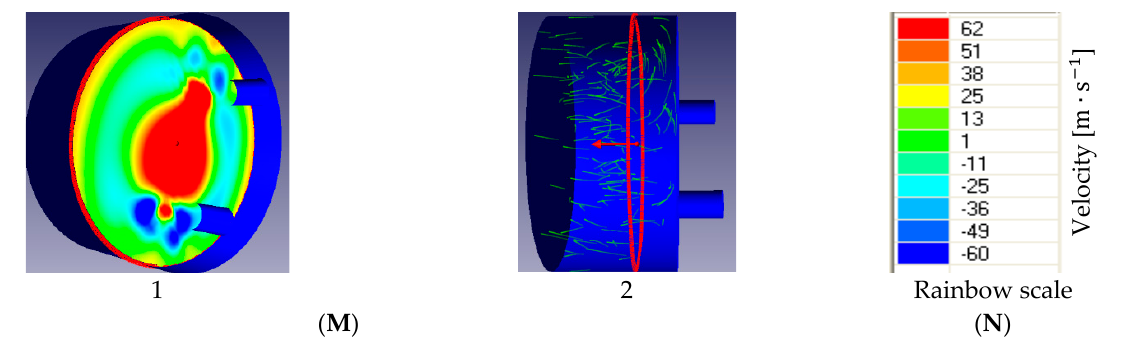
Figure 4. Visualization of the flow pattern through slots of various shapes for slot models in Figure 3: ( A ) for model (a); ( B ) for model (b), r = 0.35 mm; ( C ) for model (b), r = 0.70 mm; ( D ) for model (b), r = 1.59 mm; ( E ) for model (c); ( F ) for model (d); ( G ) for model (e); ( H ) for model (f); ( I ) for model (g); ( J ) for model (h); ( K ) for model (i); ( L ) for model (a) with shaft rotation; 1—filling from a modulus of velocity, 2—modulus of velocity isolines, 3—flash out of velocity; ( M ) for model (j); ( N ) Rainbow scale. (cid:16) p (cid:17) = 1.4 1 Table 1. Results of a numerical study . p 2 Model (Figure